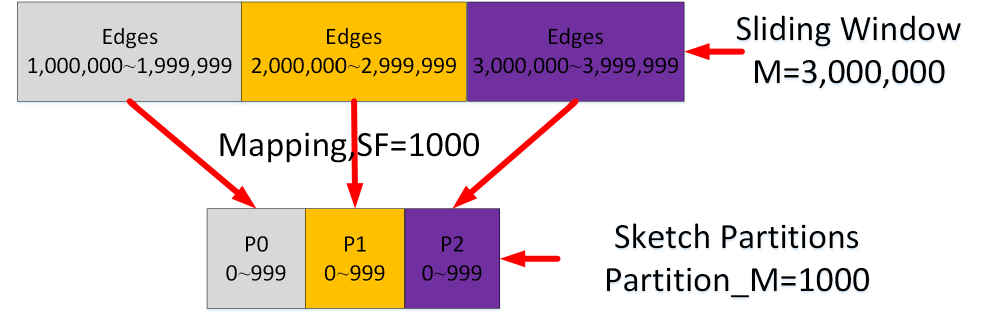
Figure 4. Mapping a graph stream into a multi-partition